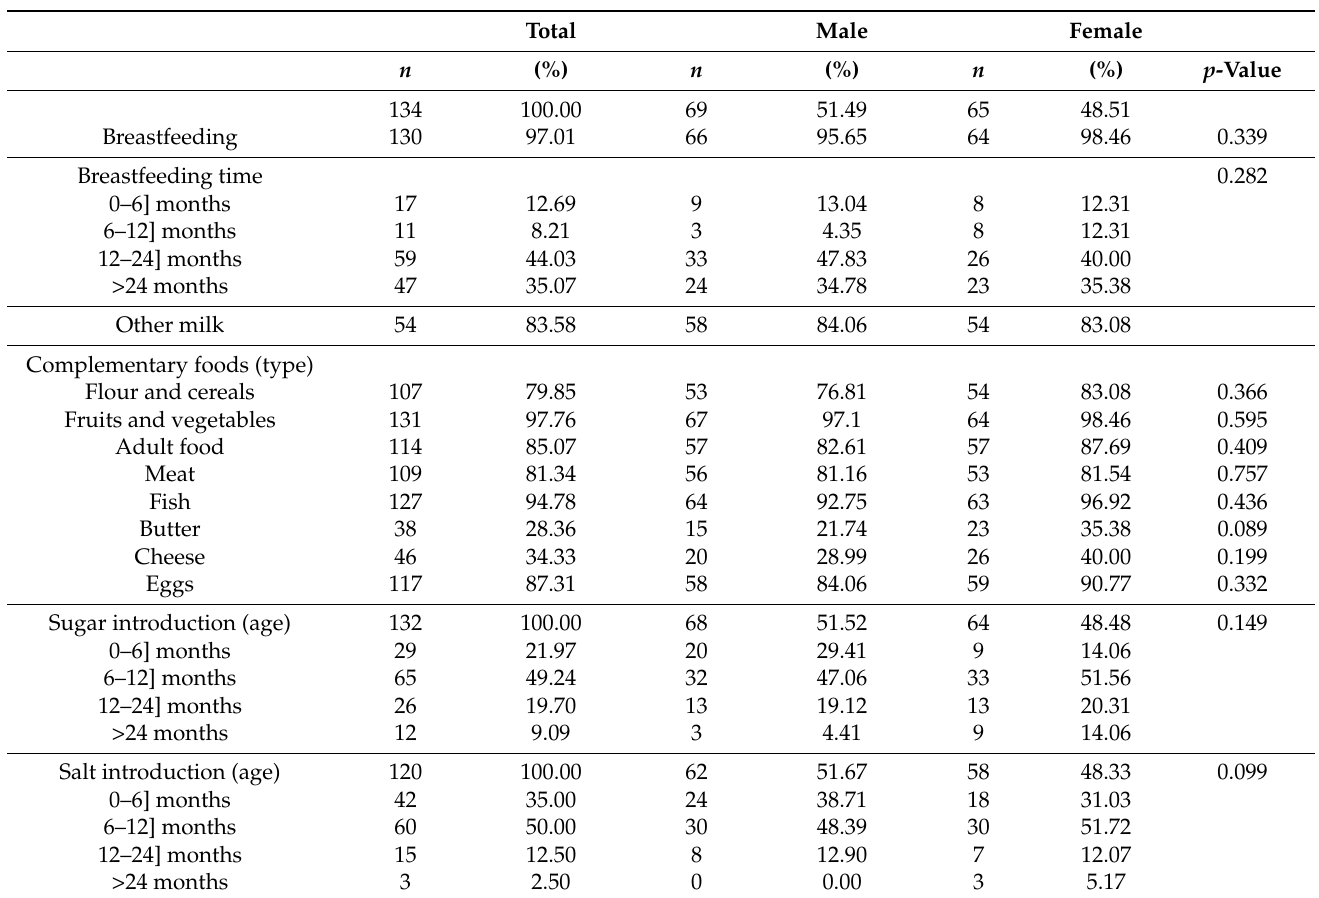
Table 2. Length of breastfeeding and complementary foods introduction in the whole population and in groups defined by